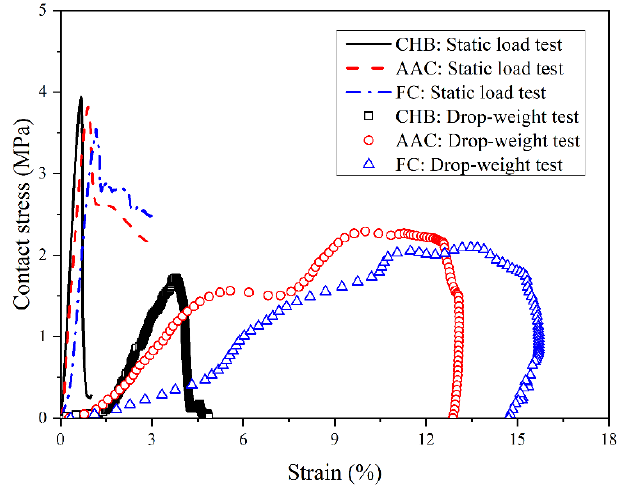
Figure 5. Contact stress–strain curves during static load and drop-weight tests. On the other hand, for the static load test, the peak stresses of the CHB, AAC and FC were 3.94, 3.77 and 3.48 MPa, respectively. The largest difference in the peak contact stress between these three types of porous concrete was smaller than 0.5 MPa. The maximum peak stress occurred for CHB, but the minimum peak stress was determined for FC. Different from the static load test, the peak contact stress was minimum for CHB and maximum for AAC in the drop-weight test. Thus, in order to avoid the influence of the compressive strength, the ratio between the peak contact stress and compressive strength was selected. The ratio for CHB was 0.44, smaller than 1. It indicates that the impact load that led to the failure of the sample was much smaller than its compressive strength. Compared with CHB, the ratios for AAC and FC were about 0.6, indicating that a small and uniform pore structure could enhance impact resistance against impact load.